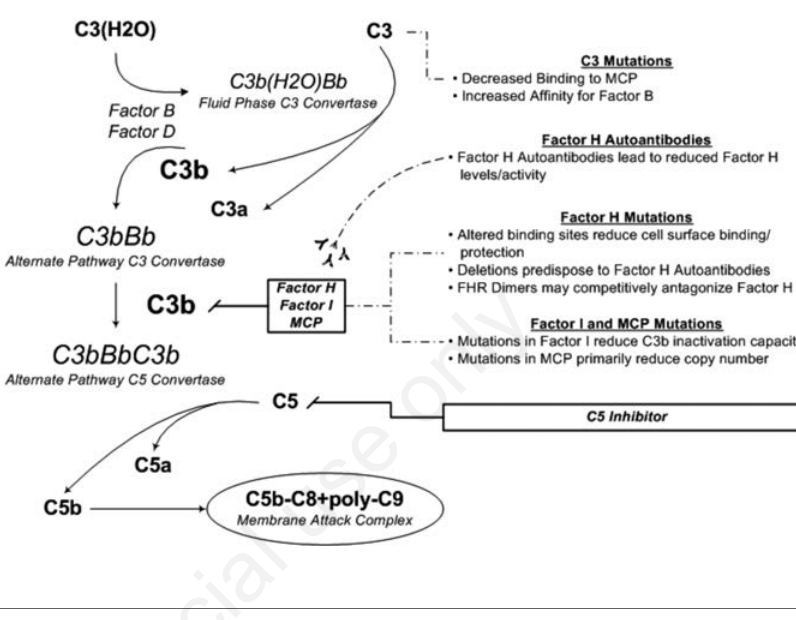
Figure 1. The alternative pathway of complement and pathophysiologic interactions with complement regulatory